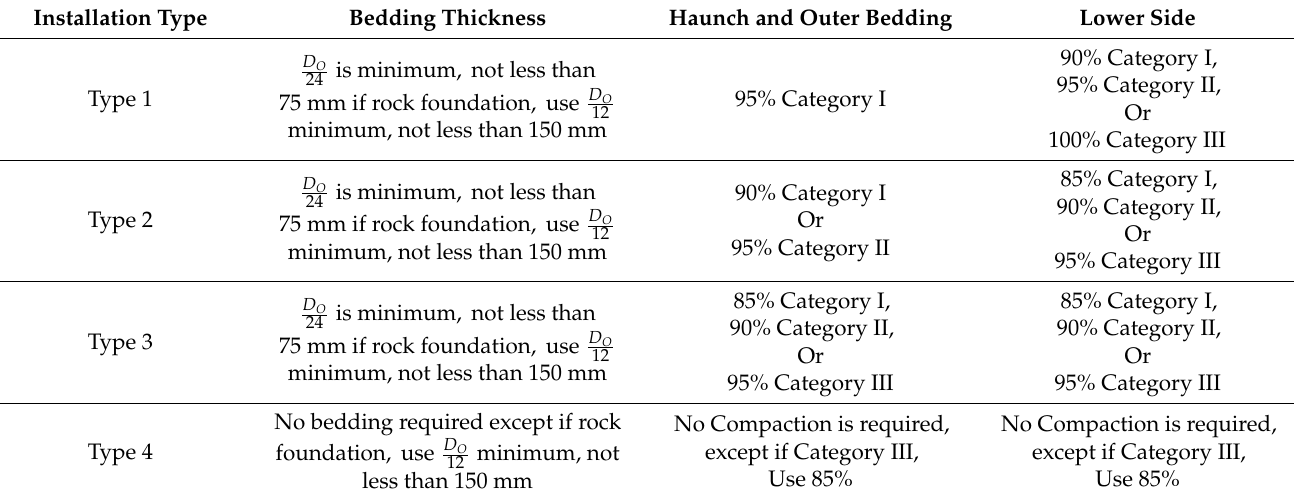
Figure 7. The geometry of the calibrated unreinforced concrete sewer pipe in ANSYS in accordance with ASTM Specification C14–15 with reference to AASHTO. Table 8. Standard installation soil and minimum compaction requirements (ASCE